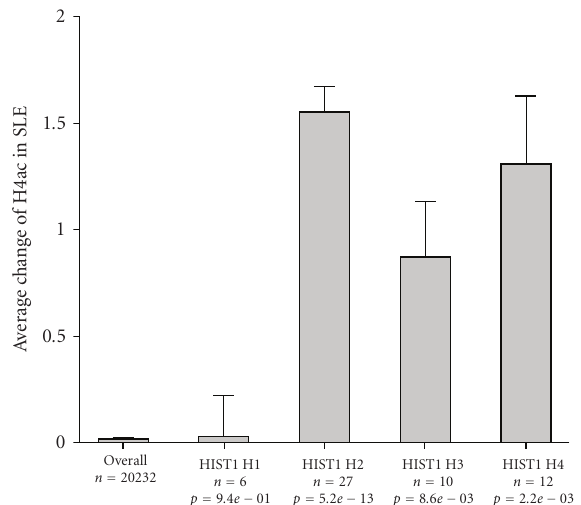
Figure 4: H4ac at histone genes. H2, H3, and H4 gene families had increased H4ac in SLE